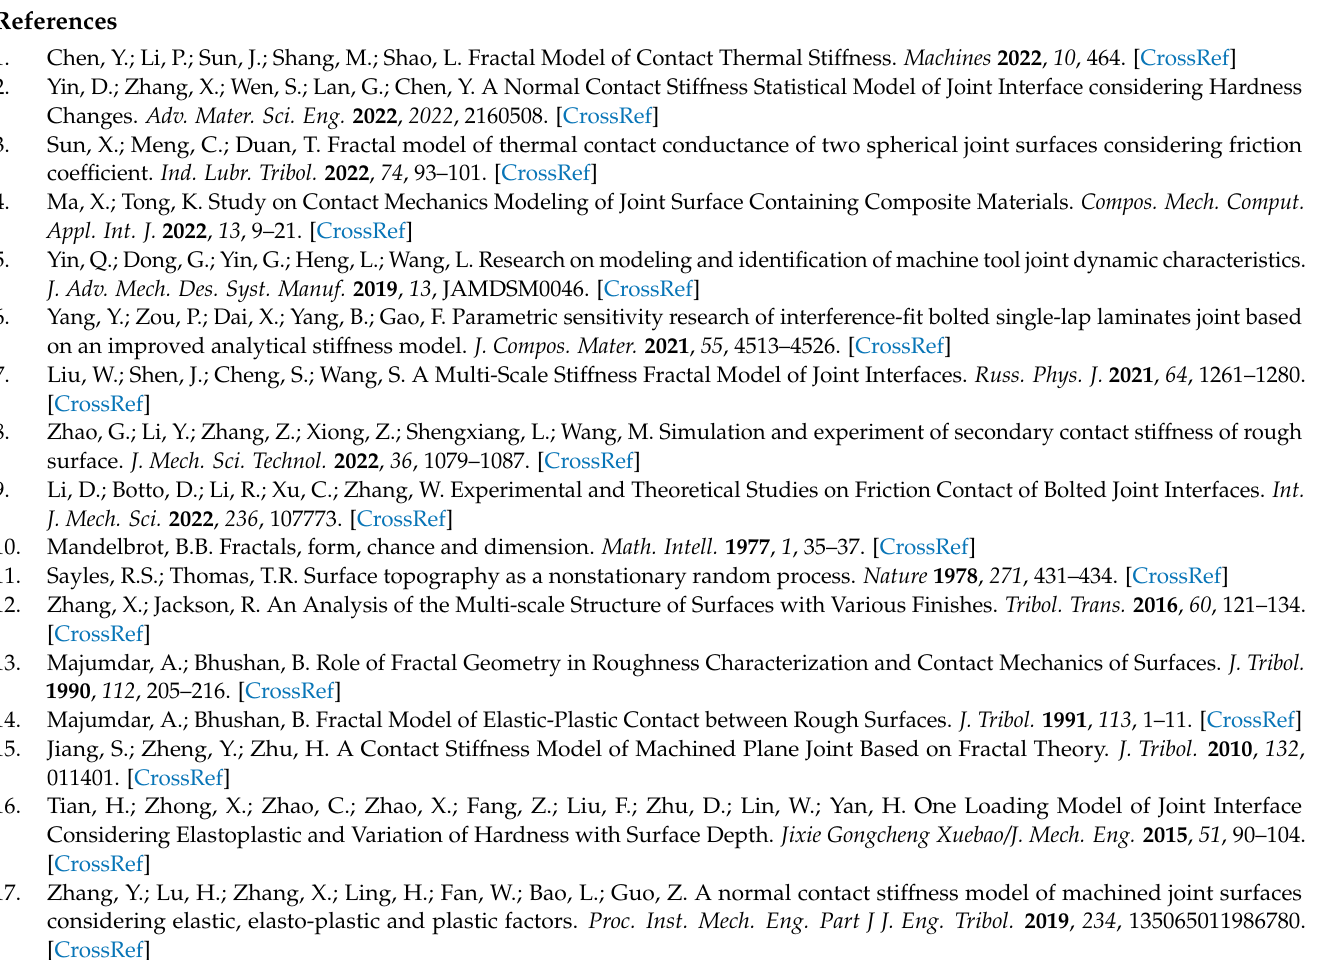
The influence of different fractal parameters on normal contact stiffness is discussed. The simulation results show that under the same normal contact load, the normal contact stiffness increases first and then decreases with the increase of D . The normal contact stiffness decreases monotonically with the increase of G . In this paper, the rationality of the simulation results is reasonably explained in combination with the shape of the asperity. However, the mechanical interface usually contains a lubricating medium in actual working conditions. The situation is not considered in the presented model and relevant work will be carried out in future